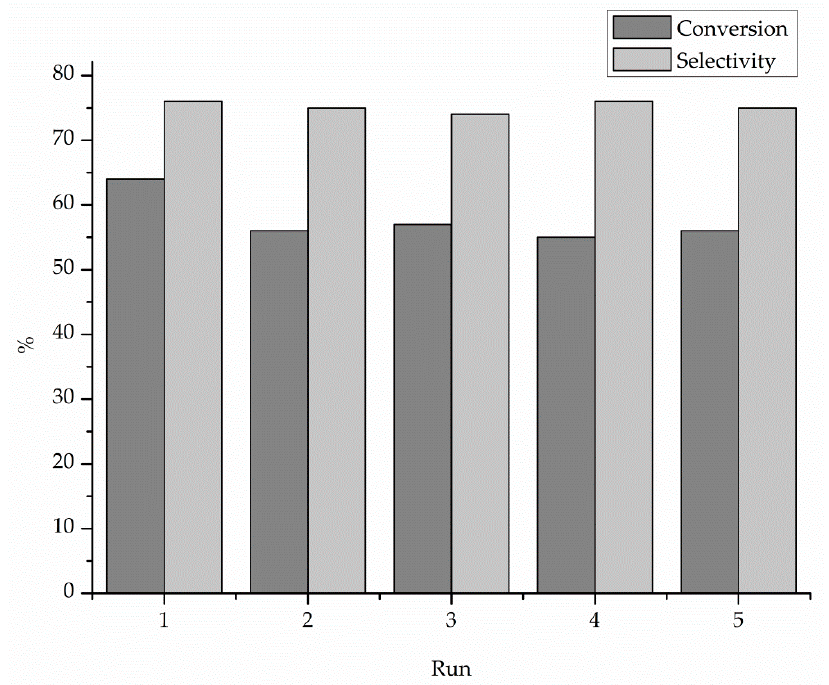
Figure 3. Recycling tests using 1% Au IW /VPO catalyst.